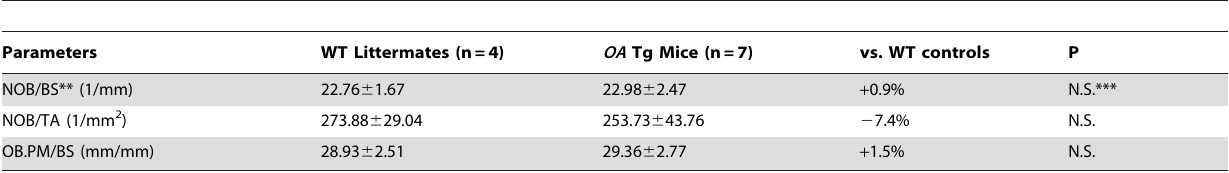
Table 5. Comparison of osteoblast parameters at secondary spongiosa* of 4-week-old female OA -Tg mice with 4-week-old female WT littermates (mean 6 SEM).